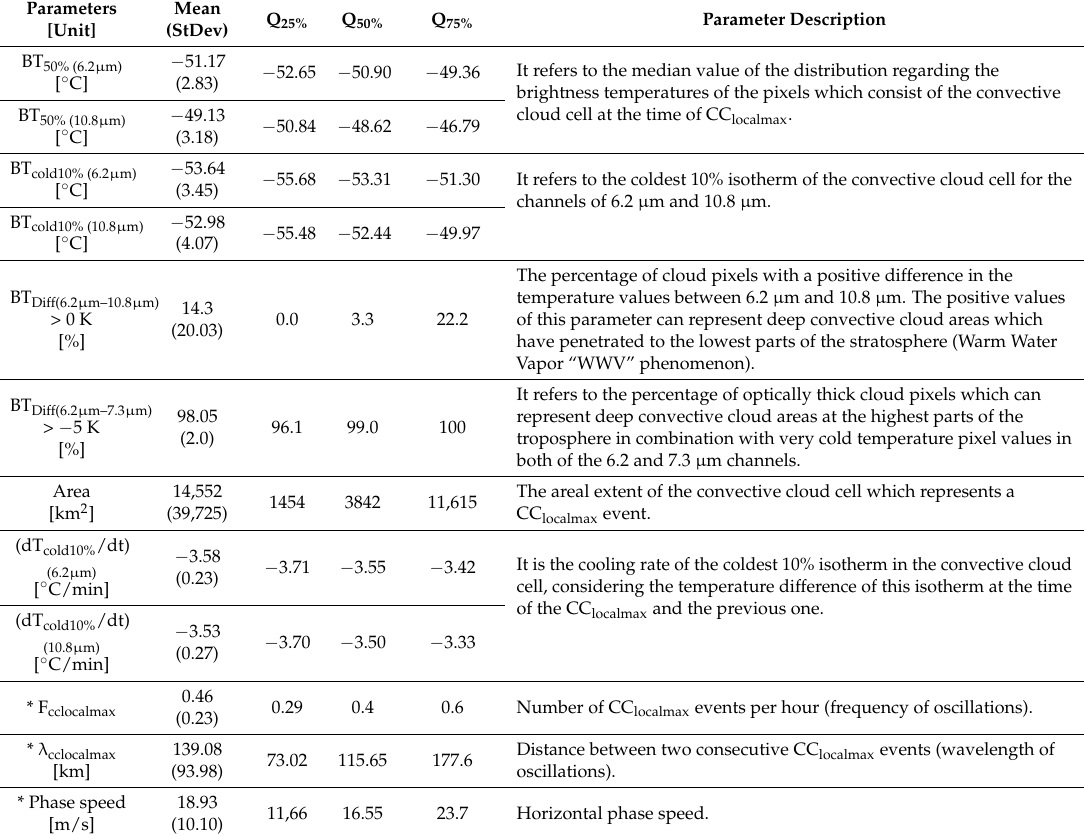
Table 2. Basic descriptive statistics for the distribution (total number of 5344 events) of the convective clouds cells which represent CC localmax